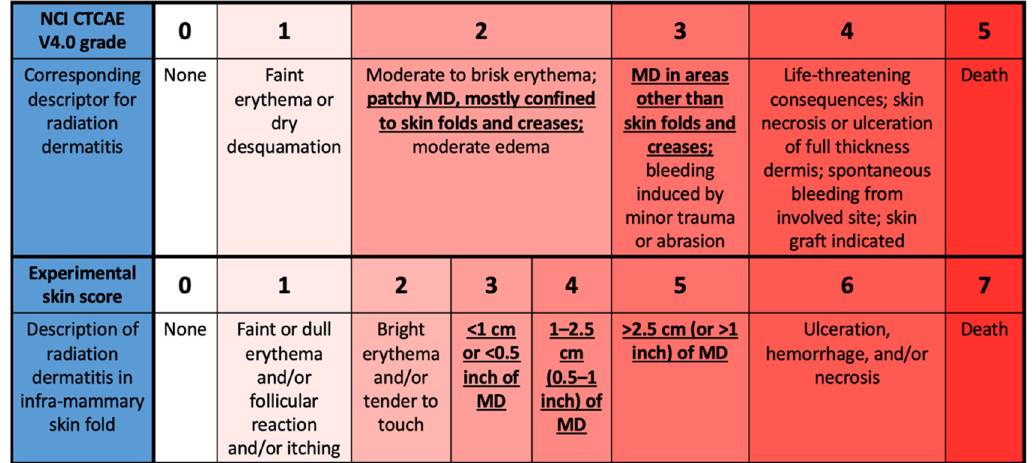
Figure 1. Modified moist desquamation (MD) scale with comparison to NCI CTCAE V4.0 grading. The differences in definition of MD between the two scales are emphasized, including the presence of MD in both grades 2 and 3 of the NCI CTCAE criteria.